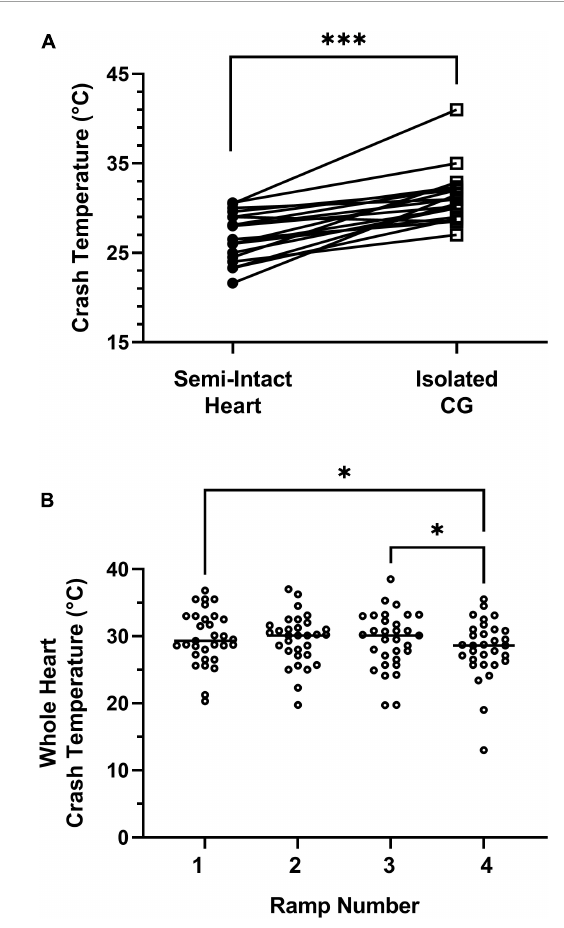
FIGURE6 Isolated ganglia crash at a higher temperature than semi-intact preparations. (A) The crash temperatures of the isolated ganglia (ICG; 31.0 ◦ C; median) were higher than those of the semi-intact preparations (26.5 ◦ C; median); Wilcoxon Sign Rank test: p < 0.001; Shapiro–Wilks test for normality: Semi-intact heart, p = 0.45; ICG, p = 0.005; N = 19. (B) Crash temperature does not increase with repeated ramps, as seen in this comparison of four repeated temperature ramps in whole heart preparations. Although there were significant differences in crash temperature across hearts (Friedman repeated measures test: p = 0.008; N = 31), this reflected differences only between Ramps 1 and 4 (Dunn’s multiple comparison test, p = 0.047; N = 31) and Ramps 3 and 4 (Dunn’s multiple comparison test, p = 0.03; N = 31); Shapiro–Wilks test for normality: Ramp 1, p = 0.44; Ramp 2, p = 0.52; Ramp 3, p = 0.97; Ramp 4, p = 0.01; N = 31. In both of these cases, the median recorded for the later ramp, i.e., Ramp 4, was lower rather than higher than the median crash temperature of the earlier ramp. (Median for Ramp 1: 29.3 ◦ C; median for Ramp 3: 30.1 ◦ C; median for Ramp 4: 28.6 ◦ C). Bars in panel (B) indicate the median crash temperature. ∗ Indicates p < 0.05; ∗∗∗ Indicates p < 0.001.